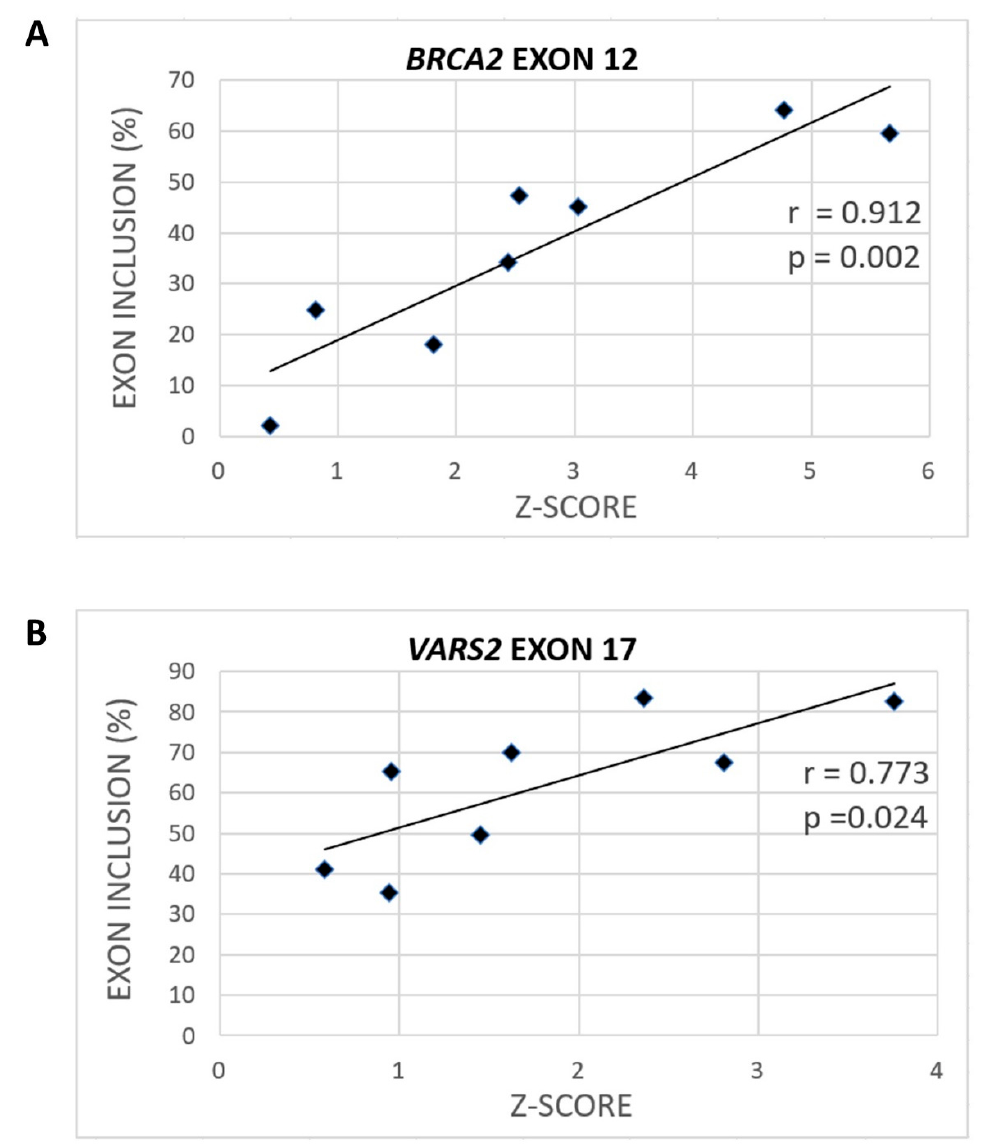
Figure 3. Various variants can have different effects on SRSF1 binding (Z-scores). The maximal correlation coefficient between exon inclusion and potential SRSF1 binding (shown as the Z-score) for BRCA2 ( A ) when using the SRSF1 binding site starting at the − 1 position and VARS2 ( B ) when starting at the − 4 position is shown.